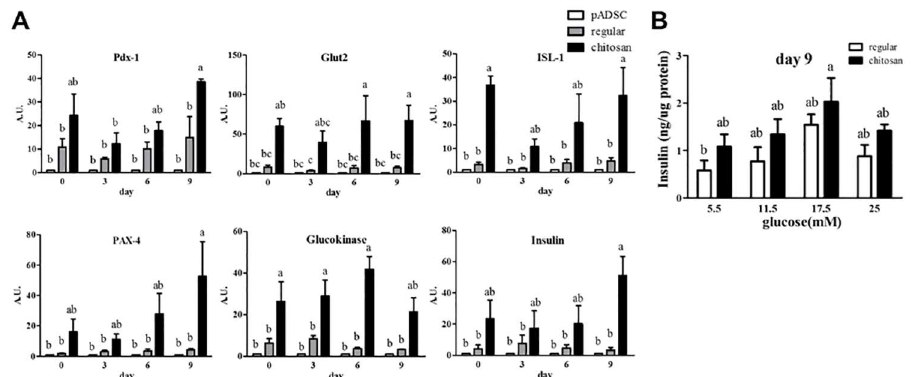
Fig 4. The expression of pADSC-derived insulin-secreting cells and clusters after withdrawing the PILC differentiation medium for 9 days. (A) Quantification of the effects of withdrawing the PILC differentiation medium on the mRNA expressionof β -cell differentiation-associated genes in pADSC-derived PILC. The differentiation medium was withdrawnfrom 0 to 9 days. Total RNA was extracted from the clusters and analyzedby real-time PCR as describedin the text. Values were normalizedto β -actin and expressedas mean ± SEM, n = 6. * , P < 0.05. (B) Quantification of insulinsecretionlevel from PILCs in response to a glucosechallenge on withdrawalday 9. PILCs from day 9 of withdrawal were starved overnightand treated with the indicatedconcentrations of glucosefor one hour. Valueswere obtainedby ELISA analysisas describedin the text, normalized against protein concentrations and expressedas mean ± SEM, n = 5. * , P <